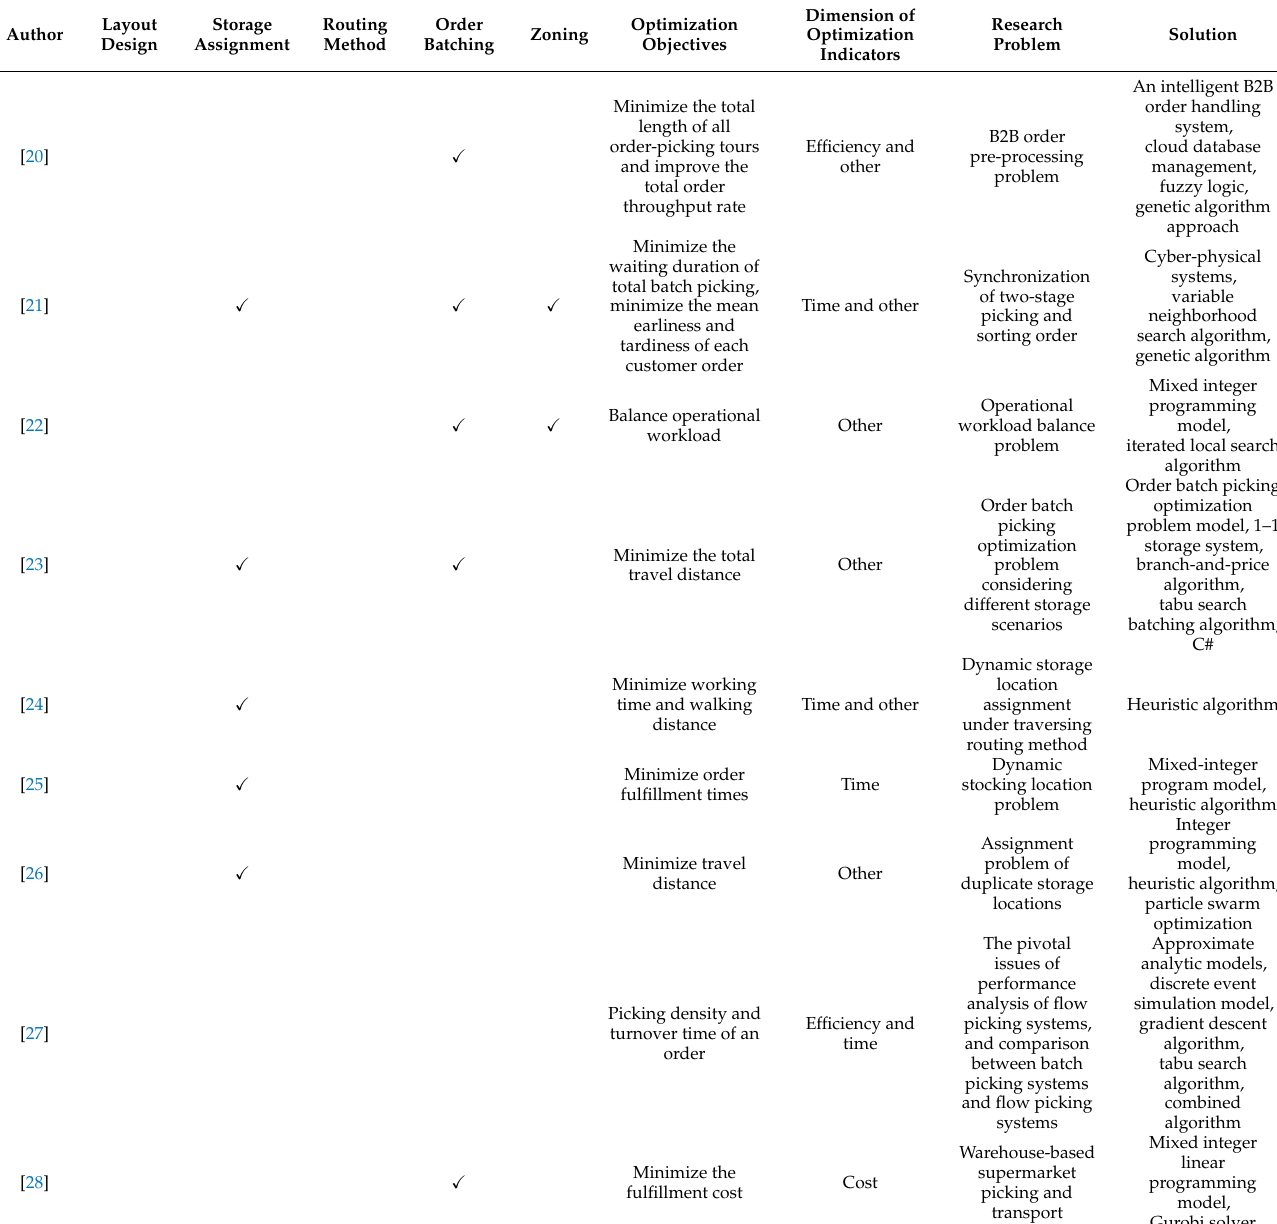
Table 4. Summary of literature related to the “picker-to-parts” picking